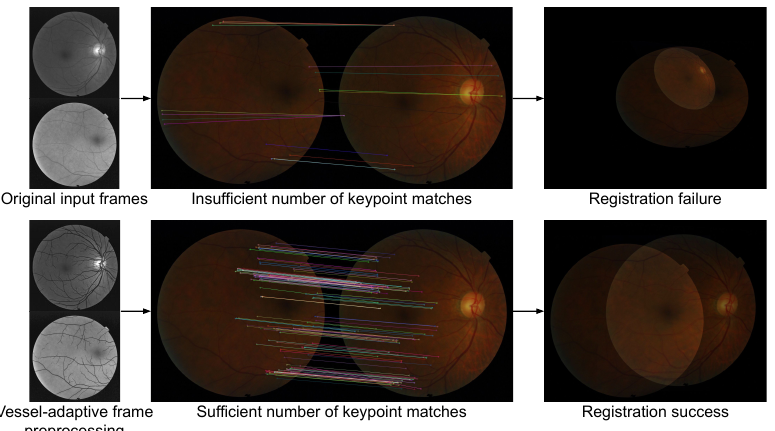
Figure 5. An example case of rigid registration failure that occurred because too few keypoint matches were established. We include a validity test, based on the difference of pixel area before and after the transform, so that frames, such as these, are not integrated into the